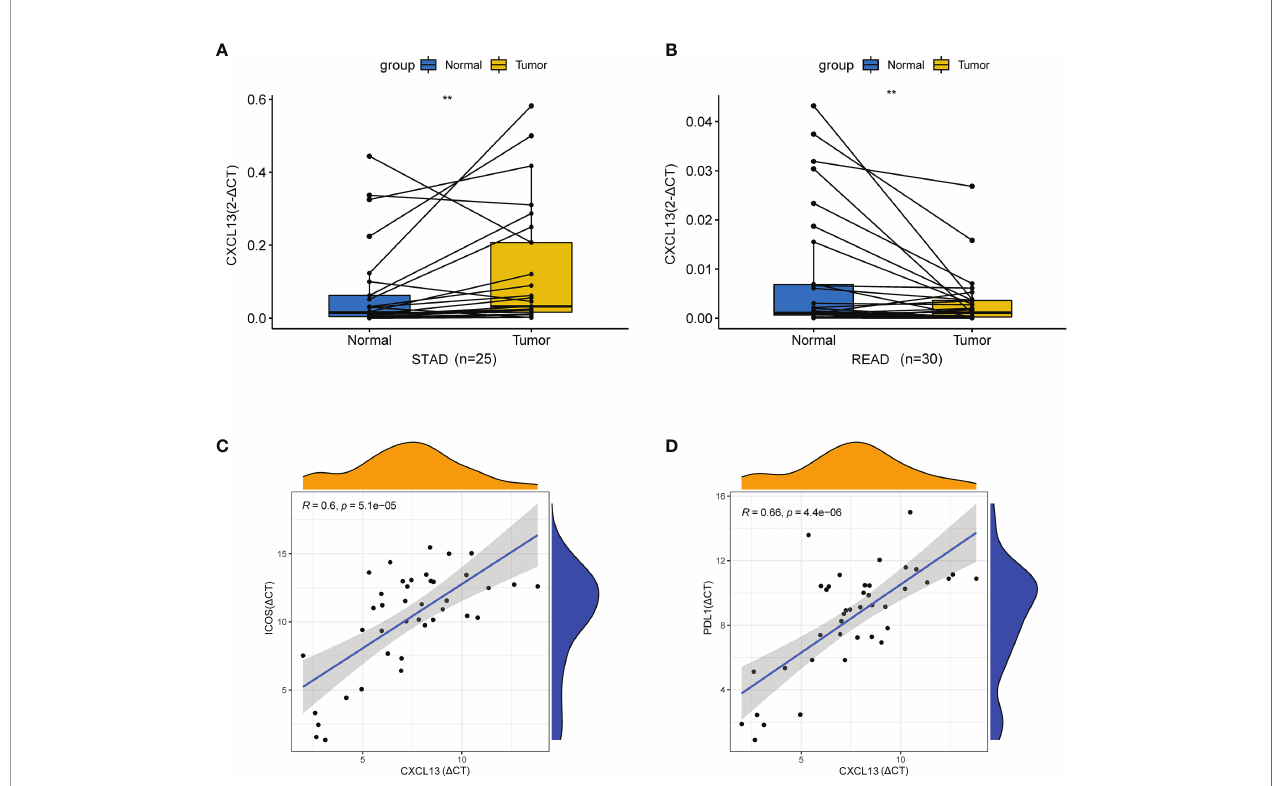
FIGURE 12 | qRT-PCR validation in vivo . (A) The mRNA relative expression of CXCL13 detected by qRT-PCR in STAD and adjacent nontumor tissues. (B) The mRNA relative expression of CXCL13 detected by qRT-PCR in READ and adjacent nontumor tissues. (C) The correlation between CXCL13 and ICOS detected by qRT-PCR. (D) The correlation between CXCL13 and PDL1 detected by qRT-PCR. **P <